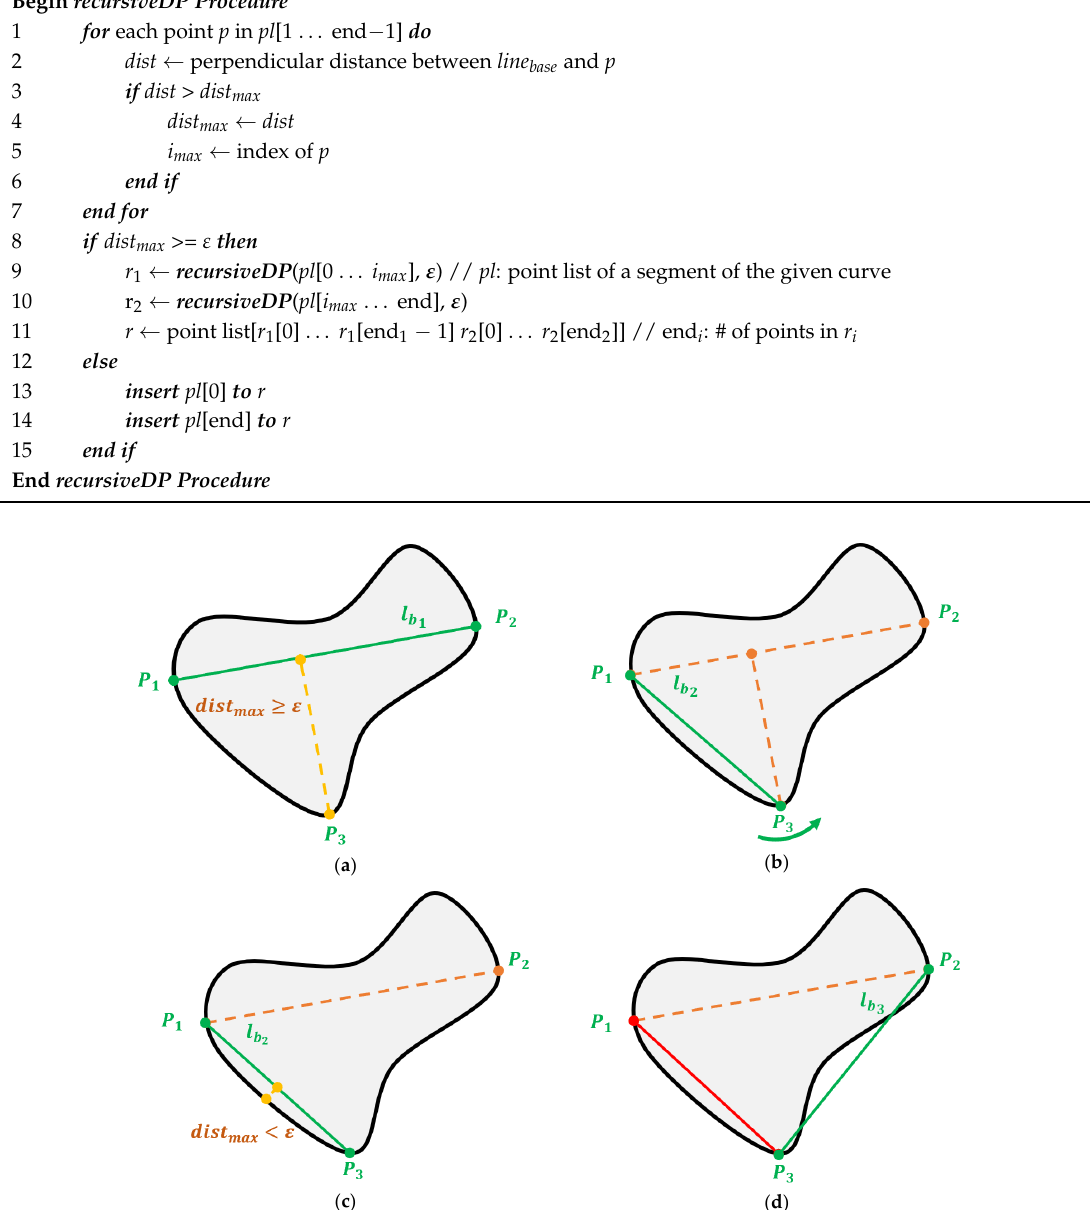
Figure 2. Douglas – Peucker (DP) process between P 1 and P 2 : ( a ) If dist max ≥ ε , then ( b ) l b2 between P 1 and dist max point P 3 is used for the next base line; ( c ) If dist max < ε , then ( d ) l b3 between P 3 and P 2 is used for the next base line.